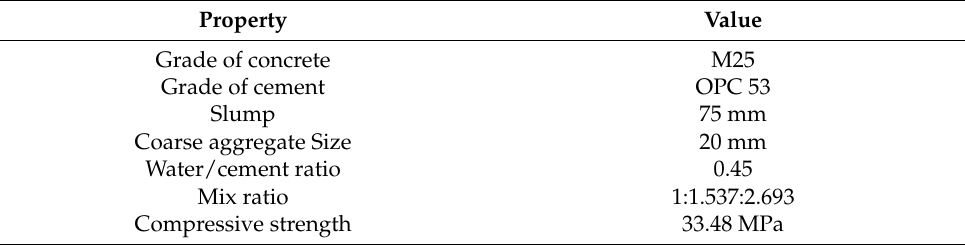
Table 1. Properties of concrete.